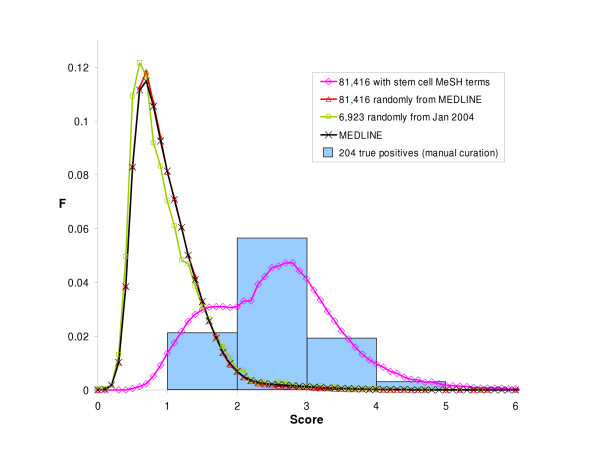
Distribution of scores in MEDLINE sets. For each of the sets of MEDLINE references analyzed in this work we plot the distribution of score values (using the average over all nouns). The complete MEDLINE (black line with X's) has a maximum around 0.65. The training set composed of 81,416 references annotated with MeSH terms related to stem cells (magenta with diamonds) has a maximum at 2.75 and a "hump" at 1.5. This type of distribution is due to the fact that this set includes both references truly related to stem cells and others that are not and agree more with the general MEDLINE background distribution of scores. The random set of 81,416 references (red with triangles) has, logically, an identical distribution to the whole of MEDLINE. The 6,923 randomly selected MEDLINE references (green with squares) used for the recall and precision test also follow the background distribution. Of those, the 204 references evaluated as stem cell related by a human expert (blue bars) had significantly higher scores than the background distribution of MEDLINE.